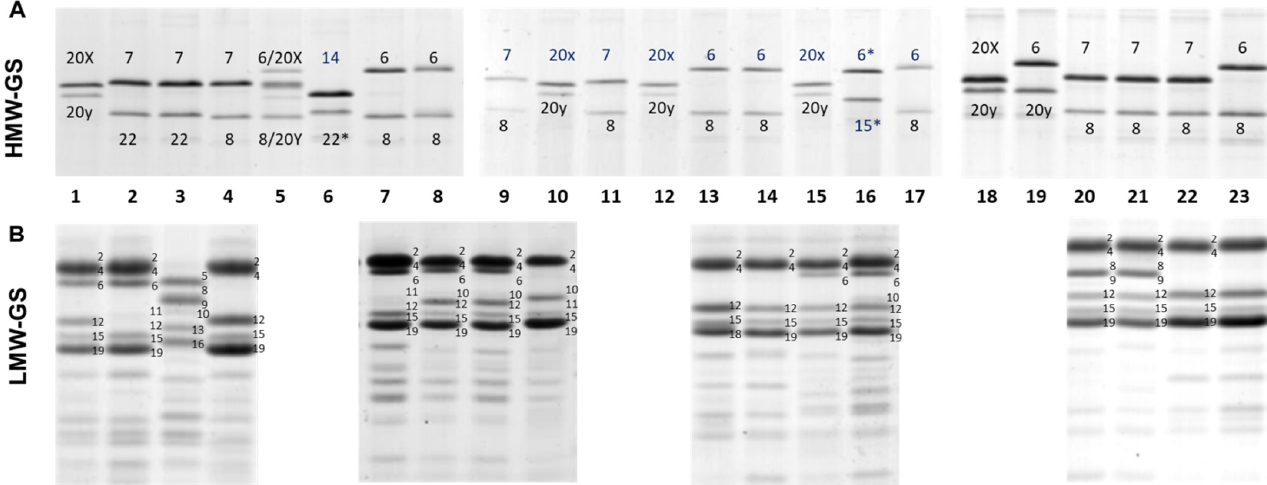
Figure 1. Representative variability of HMW-GS ( A ) and LMW-GS ( B ) found in the evaluated durum wheat collection. Genotypes are as follows: A , 1, Candeal Durumbuck; 2, CRZ-1.12; 3, GAB 125; 4, Gerardo 574; 5, Maristella; 6, Polesine; 7, Buck#33 (33.1123.16-3-4-3); 8, Langdon; 9, Coccorit; 10, Gan; 11, Cham 1 = Waha; 12, Korifla = Cham 3; 13, Focha; 14, Bha;